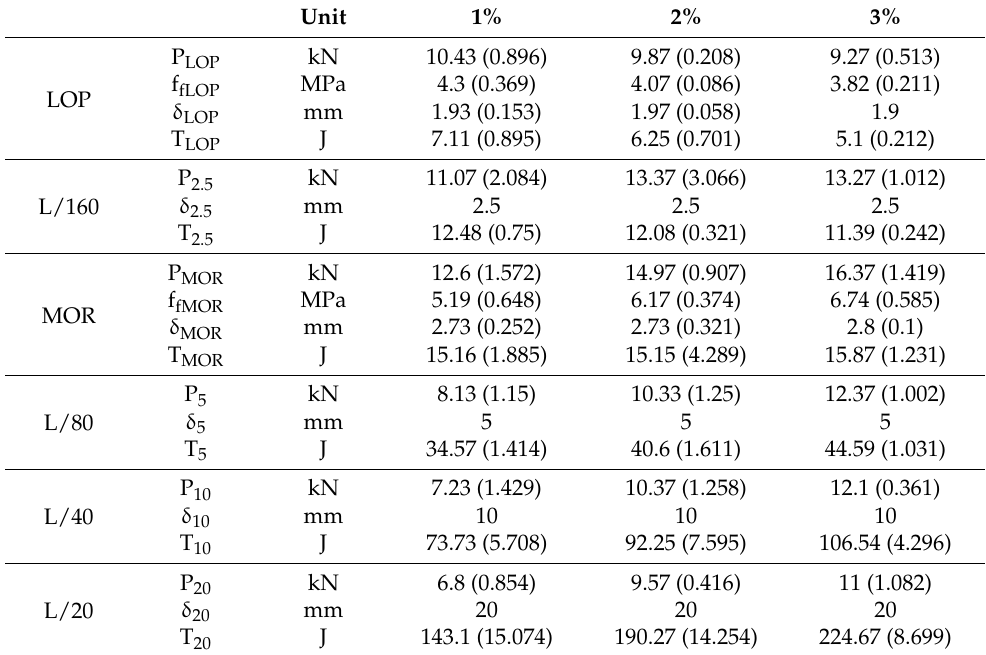
Table 8. Biaxial flexural test results.